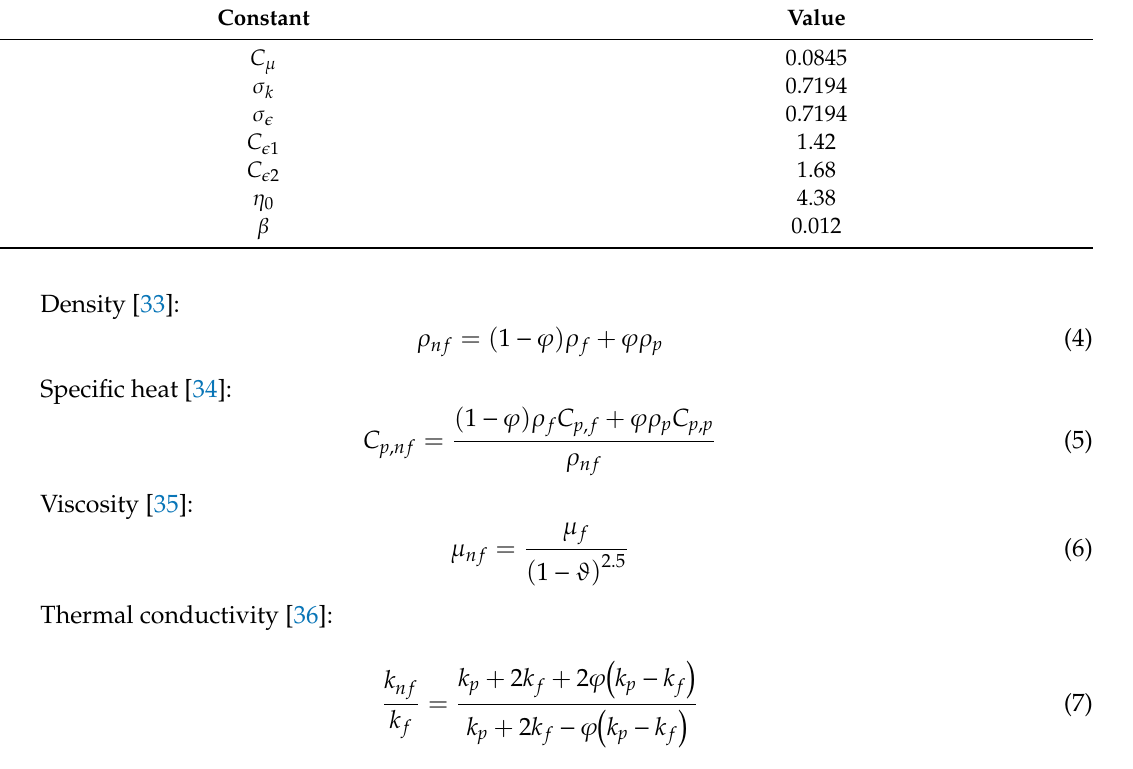
Table 2. Constant values of the transport